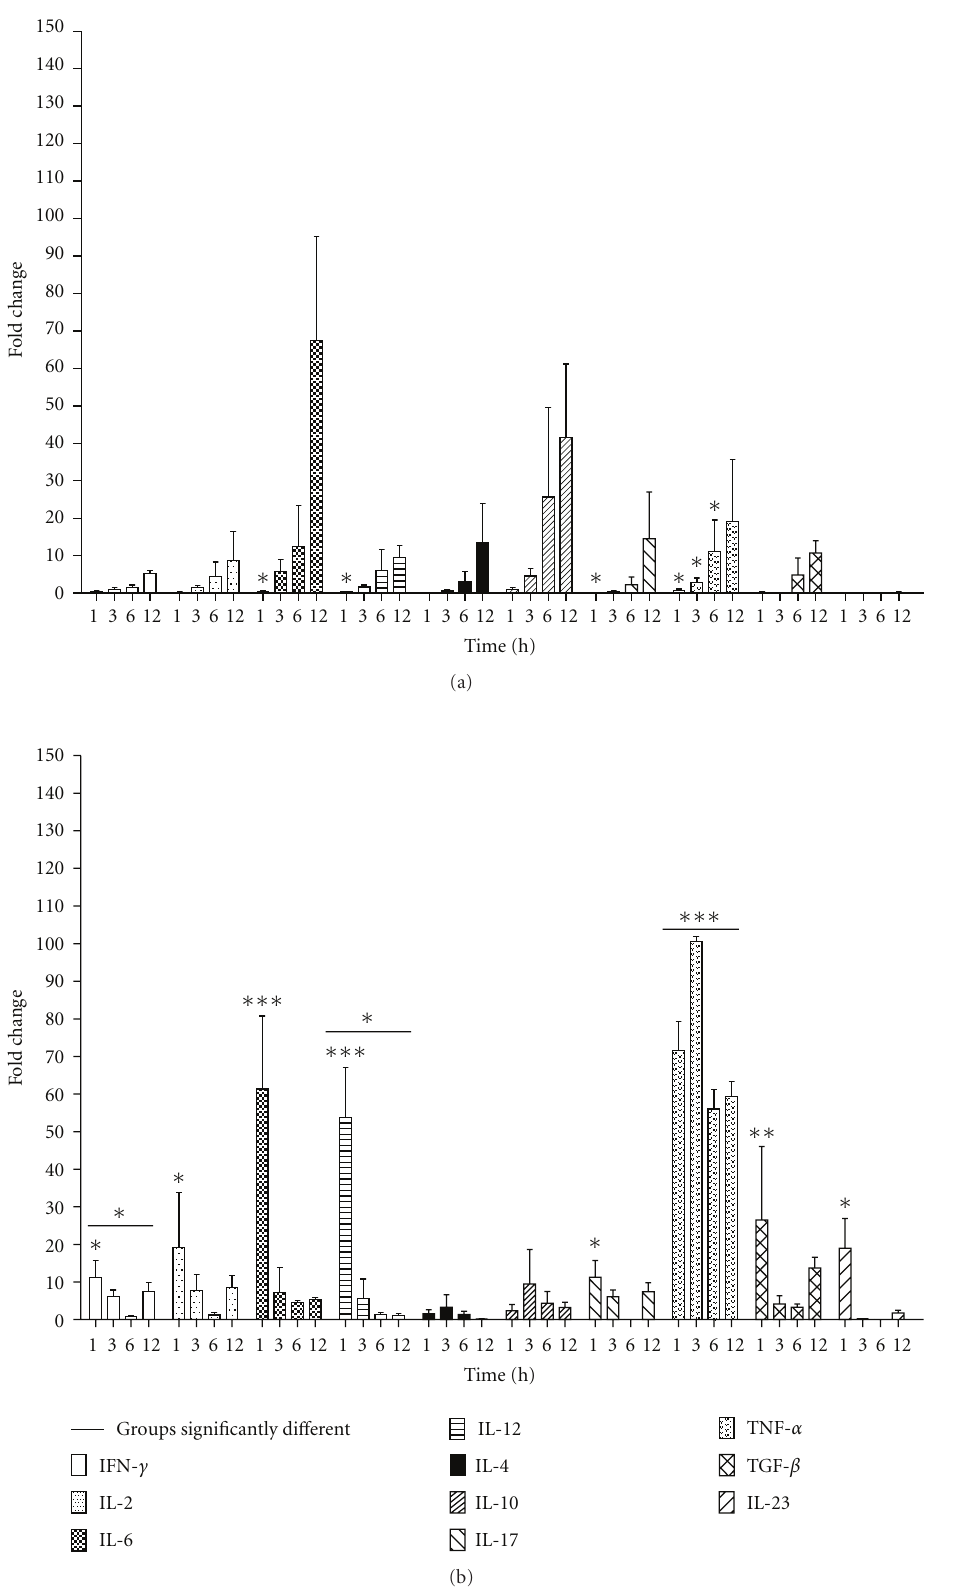
Figure 2: Cytokine expression of BMDC stimulated with OMVs. (a) BMDC stimulated with OMVs from smooth B. melitensis 16M. (b) BMDC stimulated with OMVs from rough B. melitensis VTRM1. Two-way ANOVA analysis was performed to compare results. ∗ ( P < 0 . 05); ∗∗ ( P < 0 . 01); ∗∗∗ ( P < 0 .